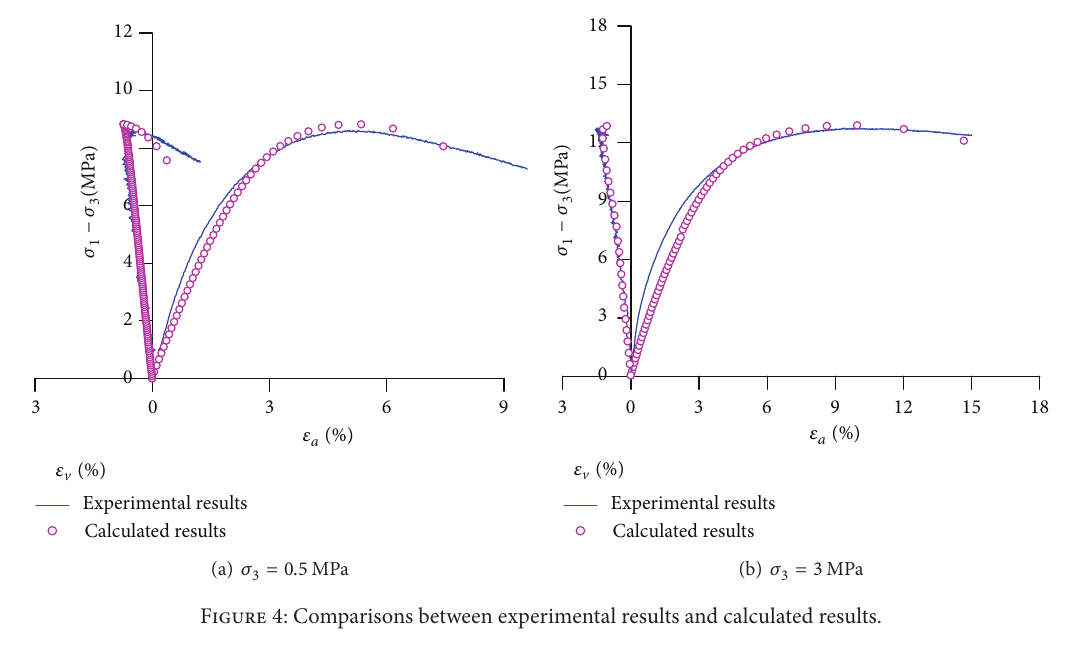
Figure 4: Comparisons between experimental results and calculated results.